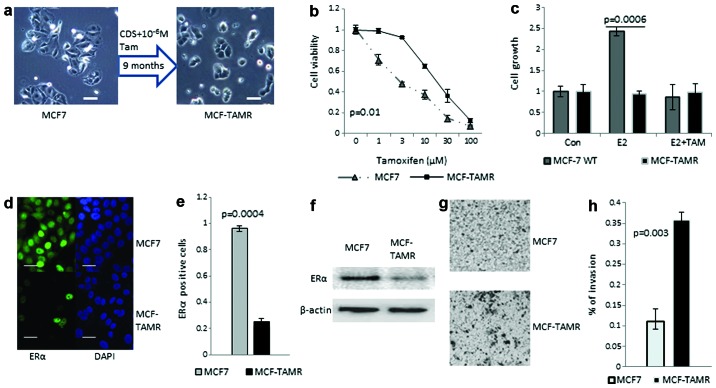
ERα is downregulated in tamoxifen resistant MCF7 (MCF-TAMR) cell line. (a) Tamoxifen resistant (MCF-TAMR) cell line has been established by culture of MCF7 cells in 10% CDS containing 1 μM tamoxifen for 9 months. (b) The effects of tamoxifen on cell viability. MCF7-WT and MCF-TAMR were treated with 0, 1, 3, 10, 30 and 100 μM tamoxifen, and viable cells were counted by a luciferase-based viability assay after 5 days. (c) E2 induction on cell growth. MCF7 and MCF-TAMR were treated with or without E2 or E2+ tamoxifen for 24 h. Then cell growth was measured by an MTT assay (d) analysis of nuclear ERα expression in MCF7 and MCF-TAMR cell line. Immunoflourescence staining using ERα antibody (green) and scale bar 15 μm. (e) The ERα-positive cells were counted in both MCF7 and MCF-TAMR lines. (f) Immunoblot of ERα to confirm ERα expression in MCF7 and MCF-TAMR lines. Cell extracts (50 μg) were loaded in each lane, and the membranes were probed with anti-ERα and β-actin antibodies, respectively, to detect the protein. (g) Cell invasion was assessed using the Transwell invasion assay. (h) The number of invaded cells was counted by imaging (error bars indicate SD, n=3 independent experiments).